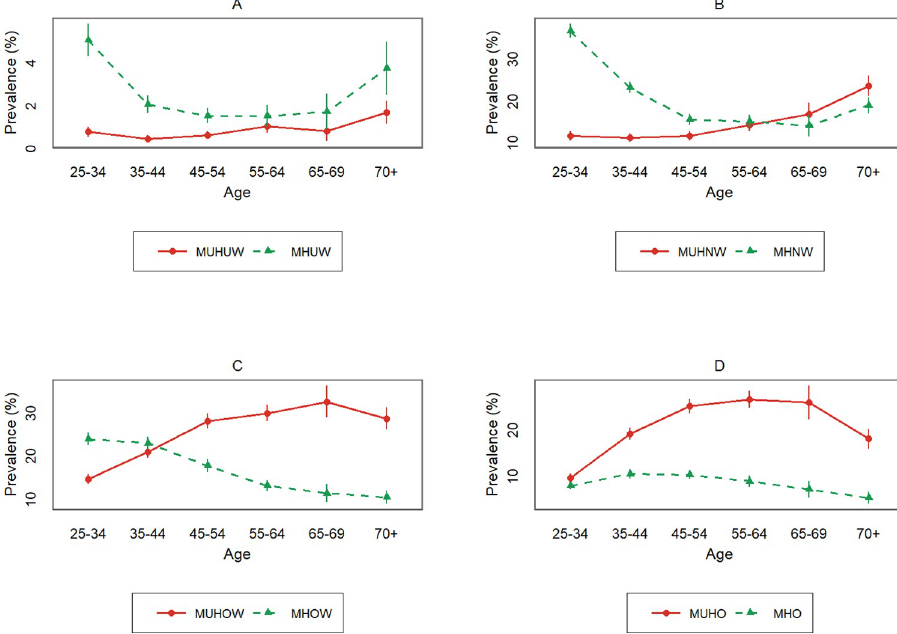
Fig 2. The prevalence of metabolically unhealthy phenotypes compared with the metabolically healthy phenotypes by age groups and body size. MUHUW: metabolically unhealthy underweight, MHUW: metabolically healthy underweight, MUHNW: metabolically unhealthy normal weight, MHNW: metabolically healthy normal weight, MUHOW: metabolically unhealthy overweight, MHOW: metabolically healthy overweight, MUHO: metabolically unhealthy obese, MHO: metabolically healthy obese.